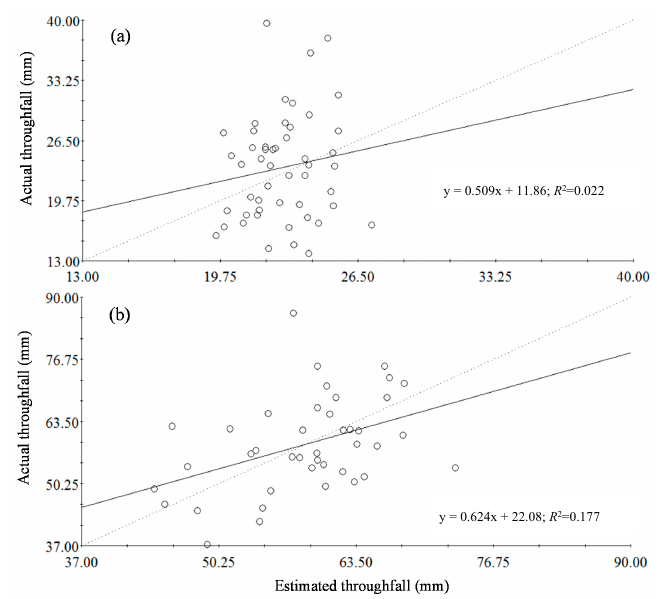
y = 0.624x + 22.08; R 2 =0.177